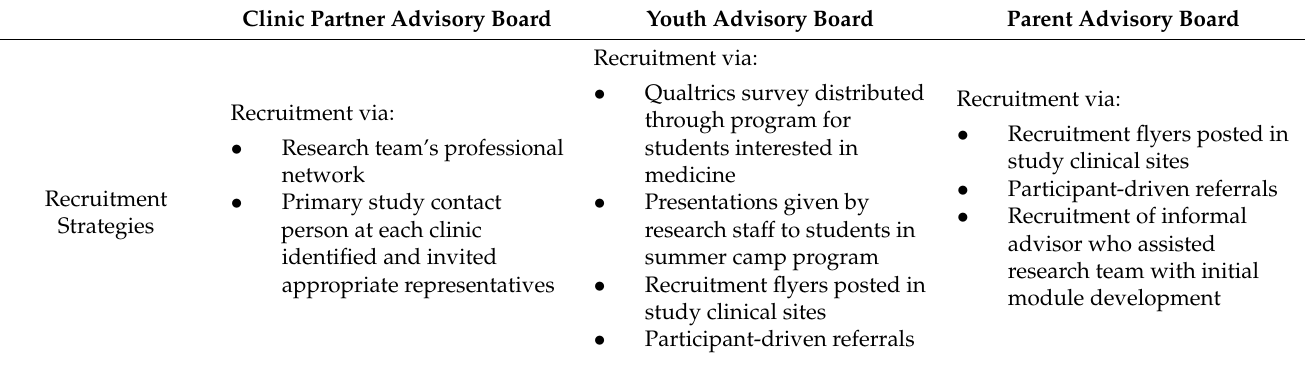
Table 2. Advisory board recruitment, engagement, contributions, and